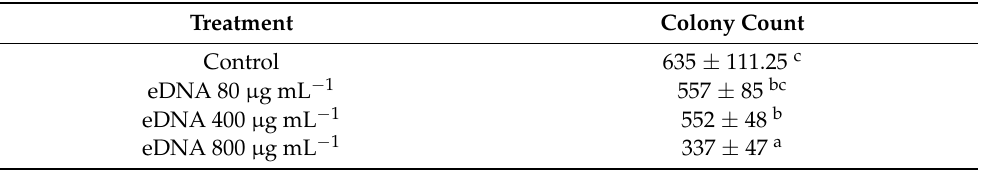
Table A2. Colony counts of Foc TR4 in the self-inhibition test. Different letters represent significantly different groups based on the results of the Duncan test.